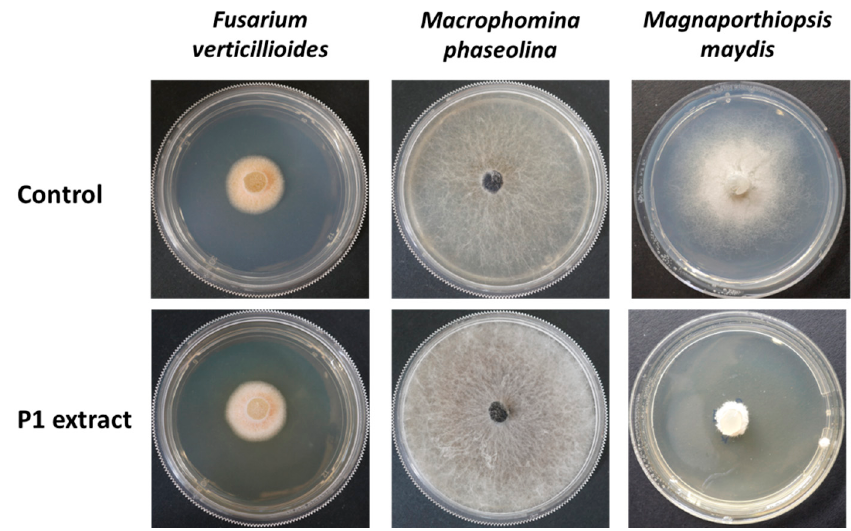
Figure 3. Bioassay of the Trichoderma asperellum (P1) secreted metabolites. The fungus liquid growth medium (P extract) was used to prepare a rich growth medium (PDA). The plates were used to test the maize post-flowering stalk rot complex [73]. This fungal group includes M. maydis, Macrophomina phaseolina, and Fusarium verticillioides . The controls are regular water-based PDAs. Representative plates’ photos were taken after six days.